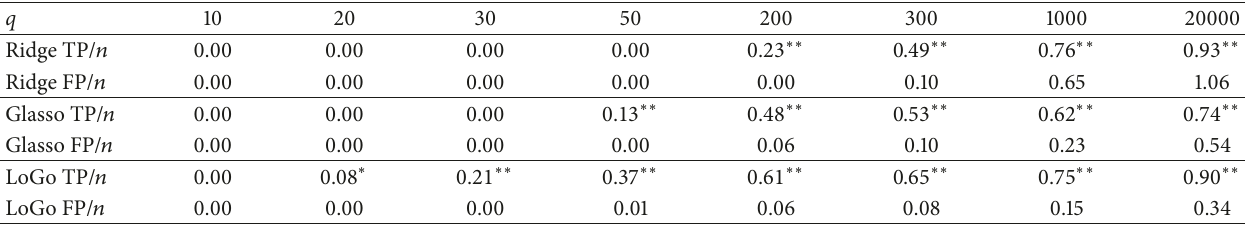
Table 1: Causality network validation . Comparison between fraction of true positive (TP /𝑛 ) and fraction of false positive (FP /𝑛 ), statistically validated, causality links for the three models, and different time-series lengths. The table reports only the case for the parameter 𝛾 = 0.1 . Statistical validation of conditional transfer entropy is at 𝑝 V = 1 % 𝑝 value. Note that LoGo can perform better than reported in this table for smaller values of 𝛾 (see Figures 1 and 2).